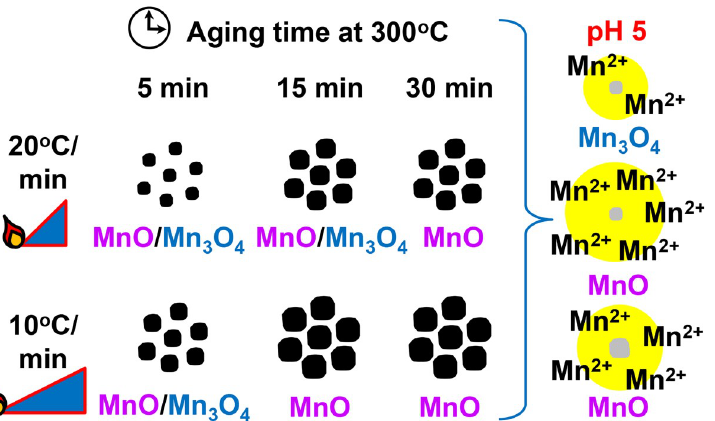
Fig 10. Schematic presentation illustrating how size and composition of MnO NPs can be fine-tuned by altering temperature ramping rate and aging time. A shorter aging time and faster ramp rate produced smaller NPs with a mixed composition of MnO/Mn 3 O 4 . Larger NPs comprised of MnO only were synthesized by extending the aging time and using a slower temperature ramp. Mn 2+ production was highest at pH 5, mimicking cell endosomes. Unencapsulated small MnO NPs released the greatest amount of Mn 2+ and had the highest MRI signal enhancement (yellow) compared to unencapsulated large MnO NPs and small Mn 3 O 4 NPs. Although there was no significant difference between large and small MnO NPs after PLGA encapsulation, both PLGA MnO NP formulations released significantly more Mn 2+ compared to PLGA Mn 3 O 4 NPs and generated much higher T 1 signal enhancement (not